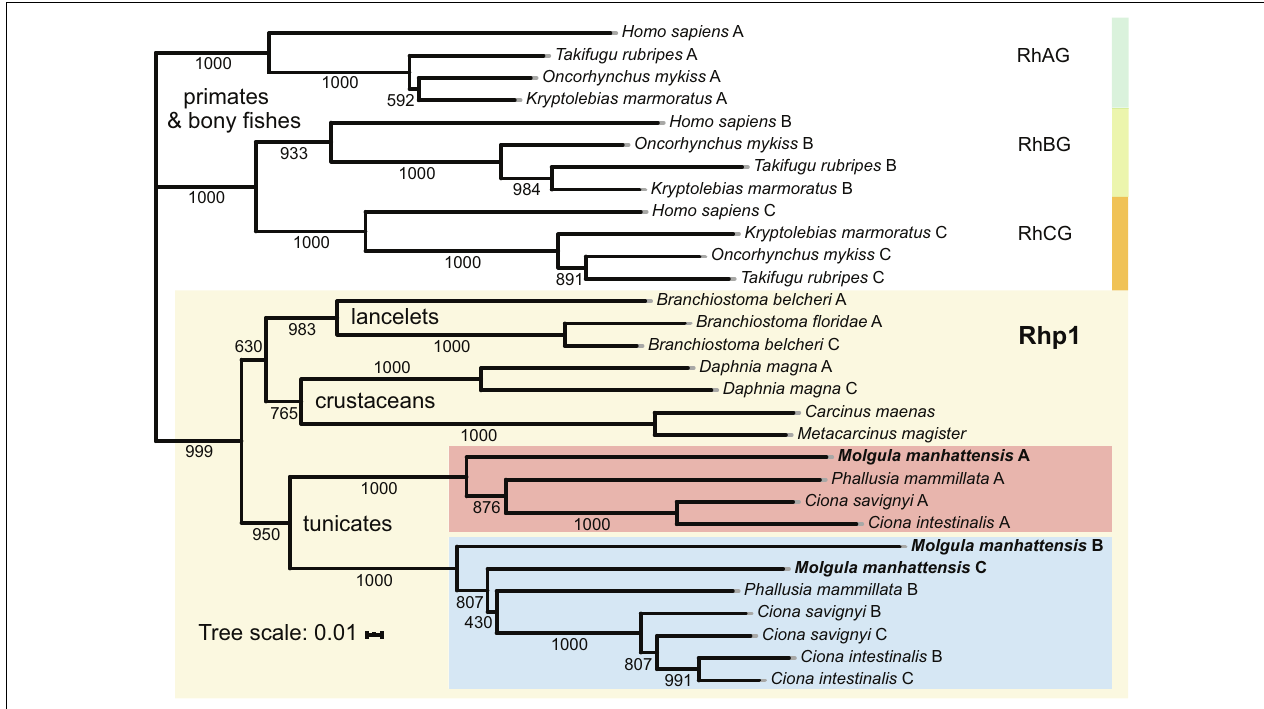
FIGURE 6 | Phylogenetic tree of amino acid sequences of the Rh gene family of selected species. Each amino sequence is presented by the name of the species from which the amino acid sequence originated. Numbers presented at each branch point represent bootstrap values from 1,000 replicates. The scale bar represents a genetic distance of 0.01 amino acid substitutions per